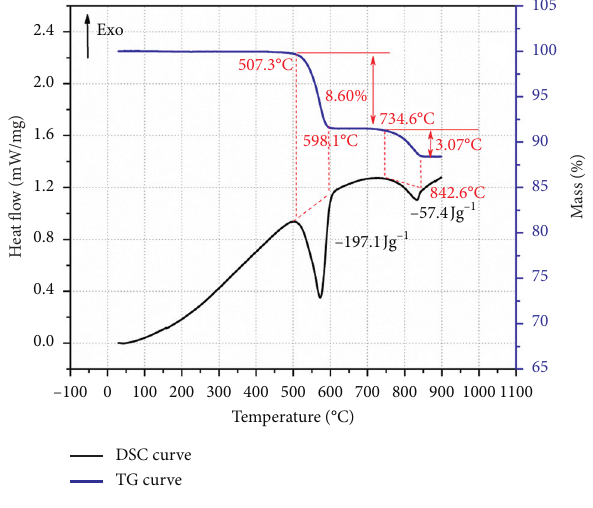
Figure 1: TG-DSC curves of micron-MnO